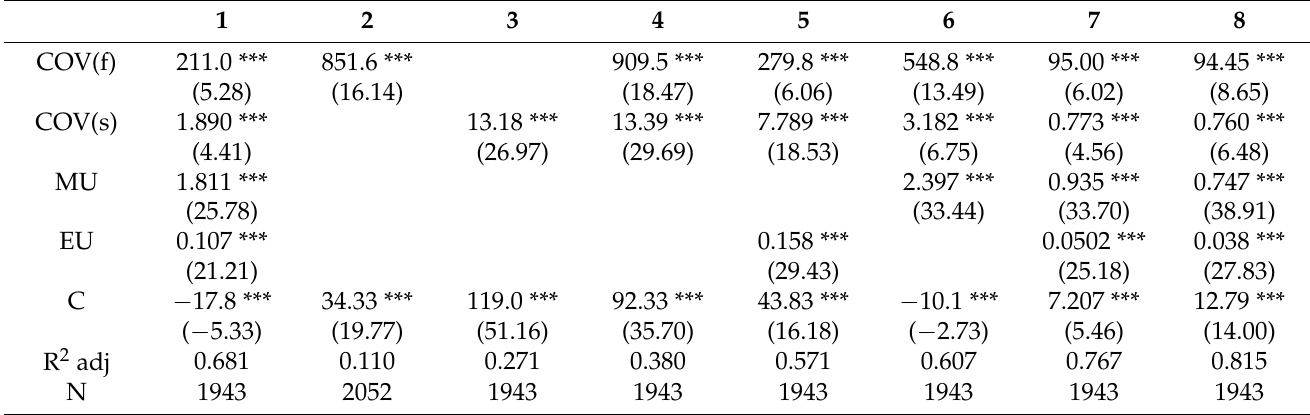
Table 9. COVID-19 death announcements, infection speed, and oil price volatility, world panel data.